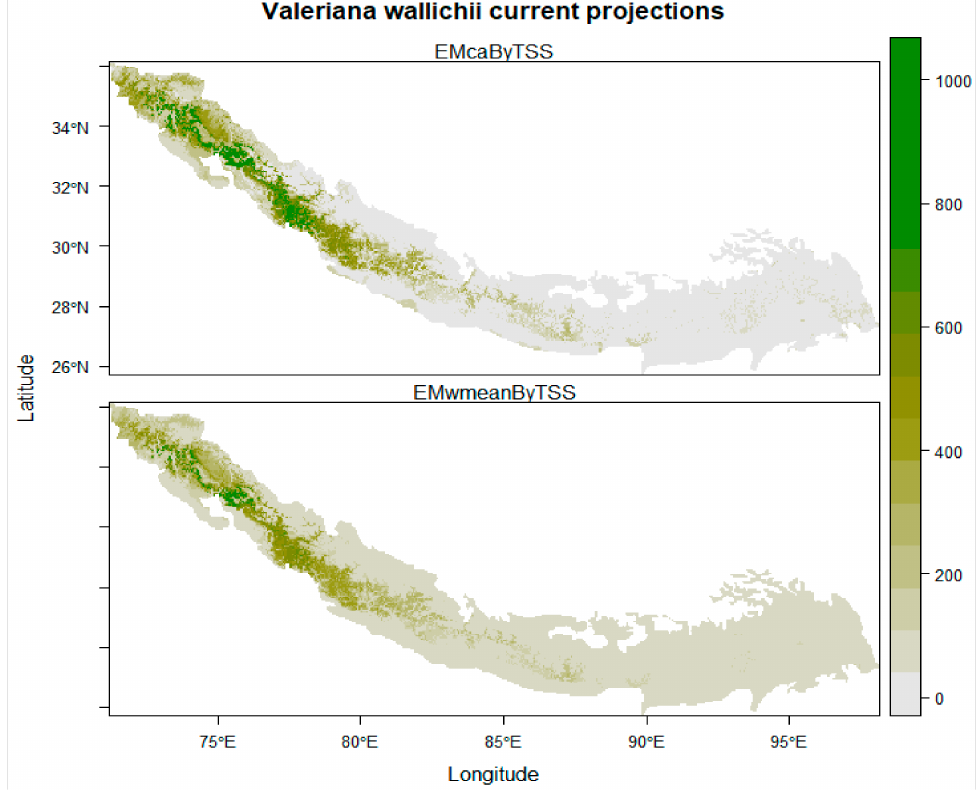
Figure 2. Current distribution pattern of Valeriana wallichii in Himalayan biodiversity hotspots. (The scale from 0 to 1000 represents the habitat suitability class where 0 depicts the absence of the species, 200–400 show least suitable areas, 400–600 show marginally suitable areas, 600–800 show moderately suitable areas, while 800–1000 show highly suitable areas). Table 5. Summary of the range change statistics for Valeriana wallichii under climate change scenarios compared to current climatic